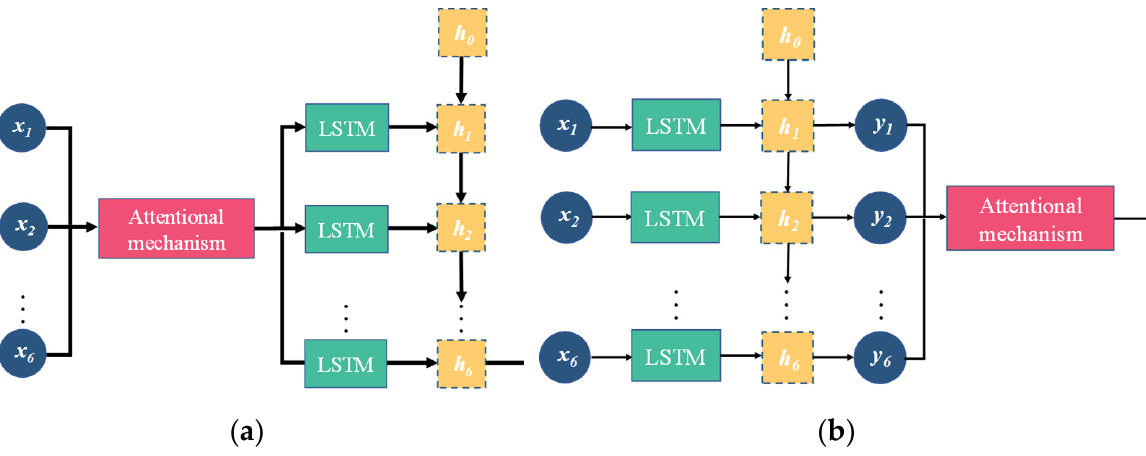
Figure 2. Schematic of the LSTM coupled with the attention mechanism: ( a ) attention mechanism preceding the LSTM layer and ( b ) attention mechanism following the LSTM layer.